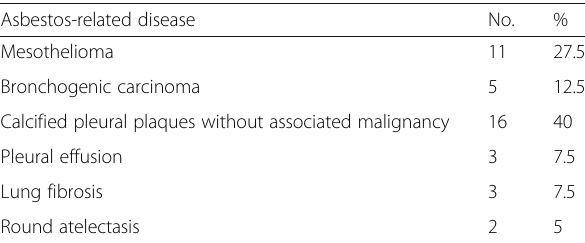
Table 1 Distribution of the studied cases according to asbestos related disease ( n = 40)